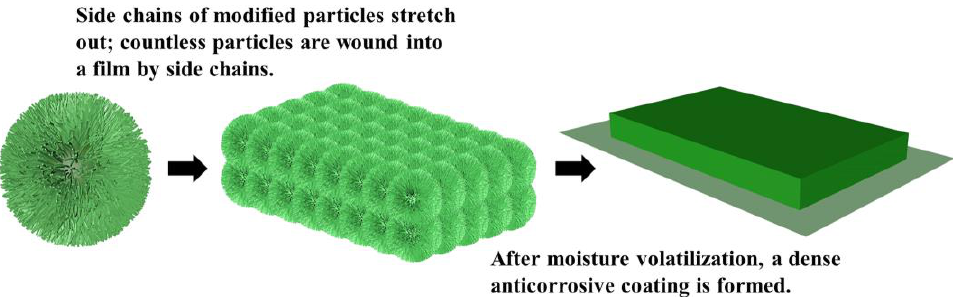
Figure 6. Forming mechanism of the modified nanoscale titania coating.